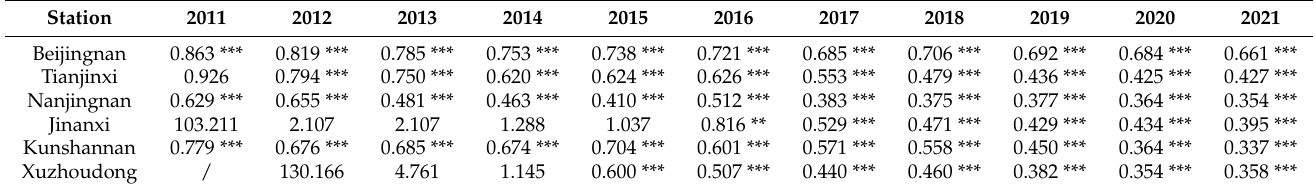
Table 2. Results of NNI